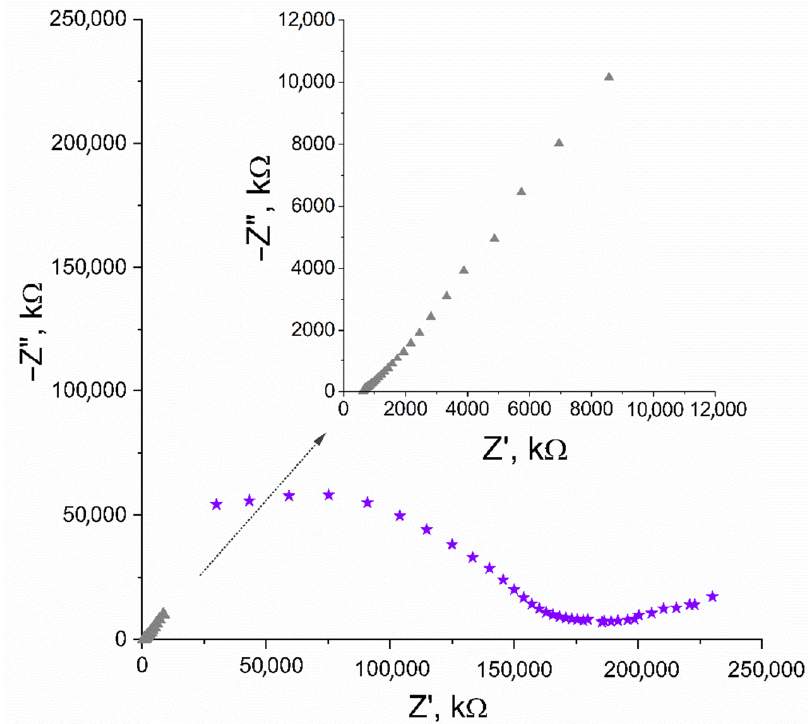
Figure 2. Nyquist plot recorded for IrO 2 ·2H 2 O solid-contact layer ( ▲ ) and GC/IrO 2 ·2H 2 O/K + -ISM electrode ( ★ ) in the 10 −2 M K + ion solution. Inset: enlarged Nyquist plot of IrO 2 ·2H 2 O solid-contact layer ( ▲ ).